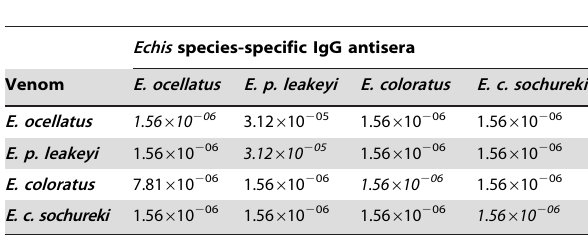
Table 1. The End Point Titre of each Echis species-specific IgG antisera to each Echis